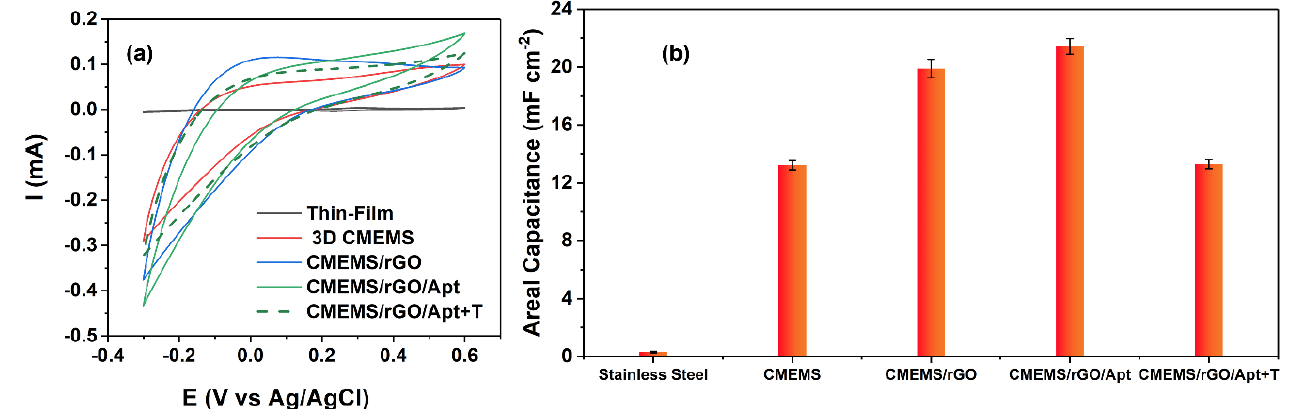
Figure 5. ( a ) CV plot of C-MEMS bare electrode and after each modification with scan rate of 40 mV s − 1 and incubation with 100 pM PDGF-BB ( b ) Areal capacitances calculated from CV plots.